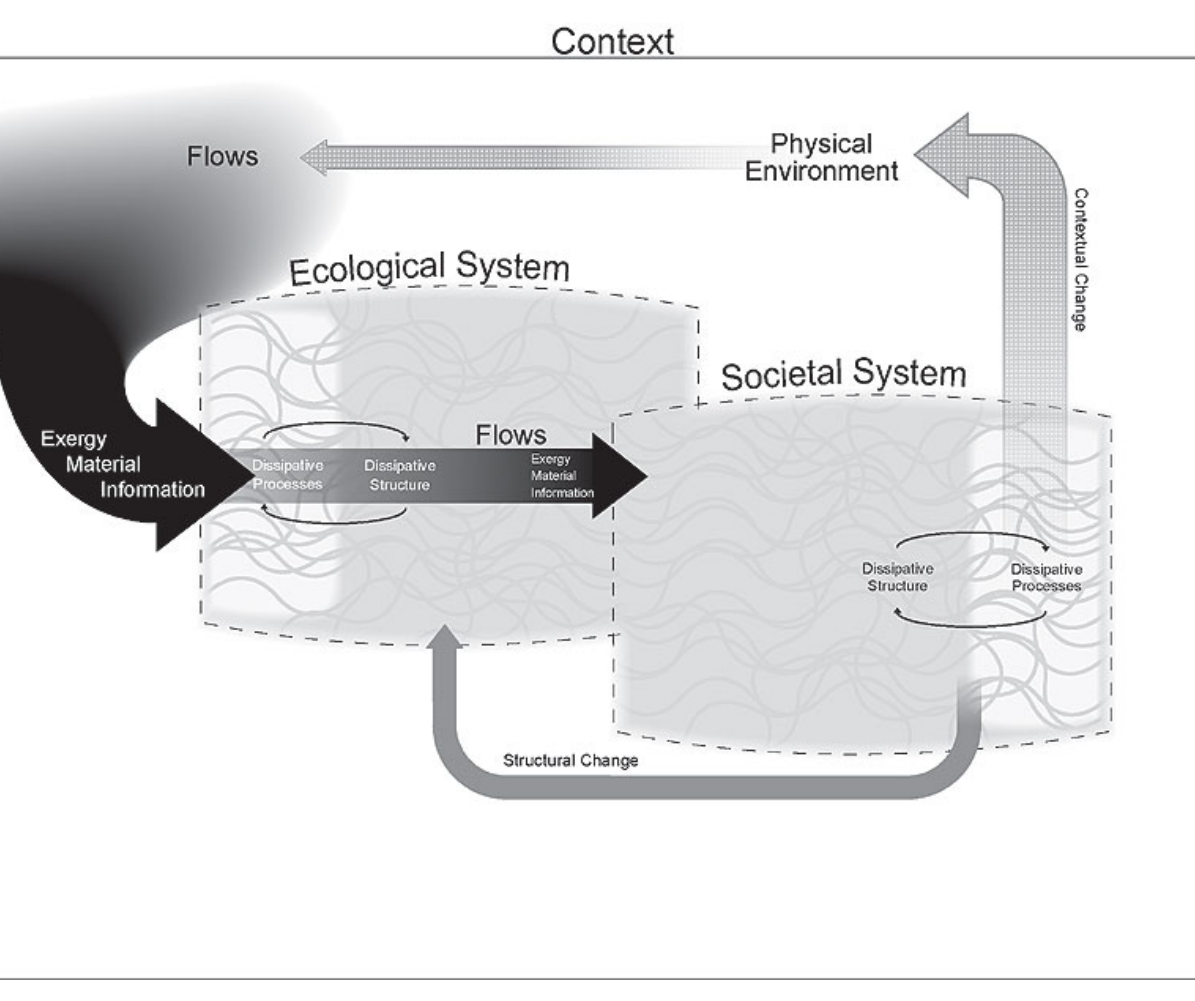
Fig. 4. A model of a single holarchical level of ecosystems and their interactions. Dotted lines represent one system forming the context for another. The arrow across the bottom represents direct societal influence on the ecological system, i.e., changing structure. The larger arrow across the top represents indirect societal influence on the ecological system, i.e., changing the context for the ecological system that cascades down to change the societal system.